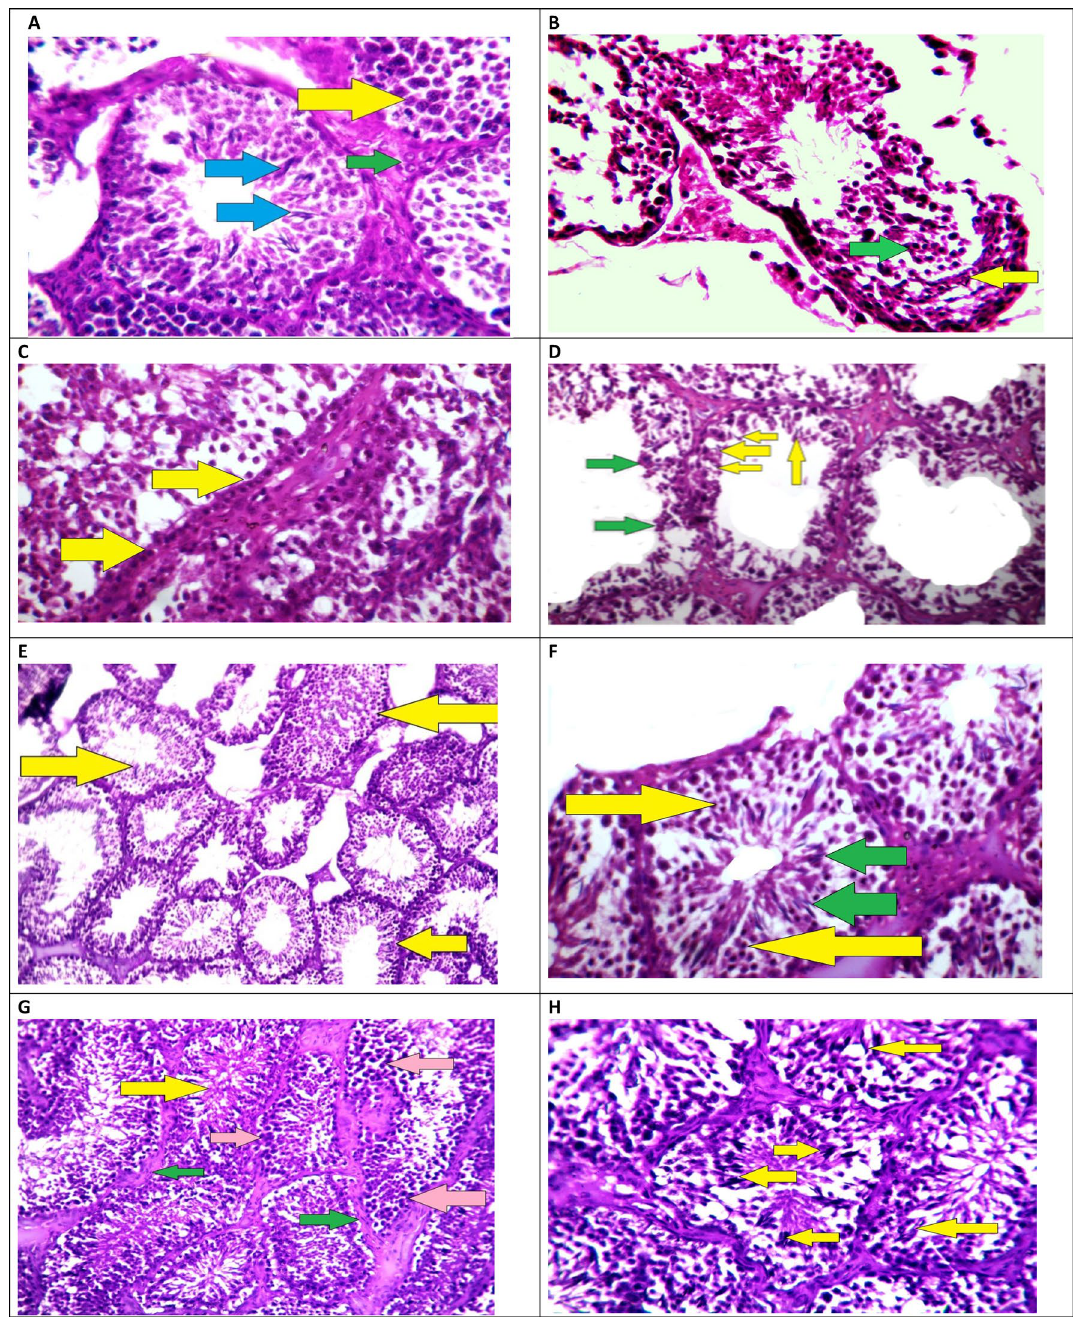
Figure 2. ( A) Male rabbit testes from a healthy control group were examined histopathologically. Primary spermatocytes with condensed chromatin differentiated nuclei (yellow arrow), spermatozoa (blue arrows), and Leydig cells (cells that make testosterone) in a rabbit’s testis (green arrow) (stain H&E ×400). ( B) Male rabbit testes from the tramadol group showed degenerated spermatozoids near the basement membrane (yellow arrow), necrosed secondary spermatocytes with dark stain nuclei (green arrow), and disruption of the normal spermatogenic series are seen in the testis of a rabbit (StainH&EX200). ( C) Testis of a rabbit pretreated with garlic before administration of tramadol showed high predominant of spermatogonium stem cells with undifferentiated nuclei (yellow arrows) (StainH&E ×200). ( D) High magnification of C image showed sperm spermatozoids with abnormal bent shapes, some with preserved cytoplasm (yellow arrows), and degenerated necrosed cells (lost their nuclei; green arrows) (StainH&EX400). ( E) Histopathological study of male rabbits testes of Tramadol and selenium group, in most of the testis tubules, histopathological examination revealed moderate to high improvement of the spermatogenic epithelium, good height and volume of spermatogenic epithelium (yellow arrows), and a few degenerated testis tubuli with low volume of spermatogenic epithelium (green arrows) (StainH&E ×200). ( F) High power of E image showed high number of secondary spermatogenic cells (yellow arrows) and healthy spermatozoids (green arrows) (StainH&E × 400). ( G) Histopathological analysis of male rabbit testes treated with Tramadol, garlic, or selenium showed a significant increase in the height and volume of the spermatogenic epithelium, a high percentage of spermatogenic stem cells (pink arrows), a high yield of healthy spermatozoid (yellow arrow), and a strong supporting interstitial tissue with myoid cells (green arrows) (stain H&E ×200). ( H) High-resolution image reveals a high yield of spermatozoids (yellow arrows) and clear evidence of normal mitotic division, indicating a normal spermatogenic series (StainH&E